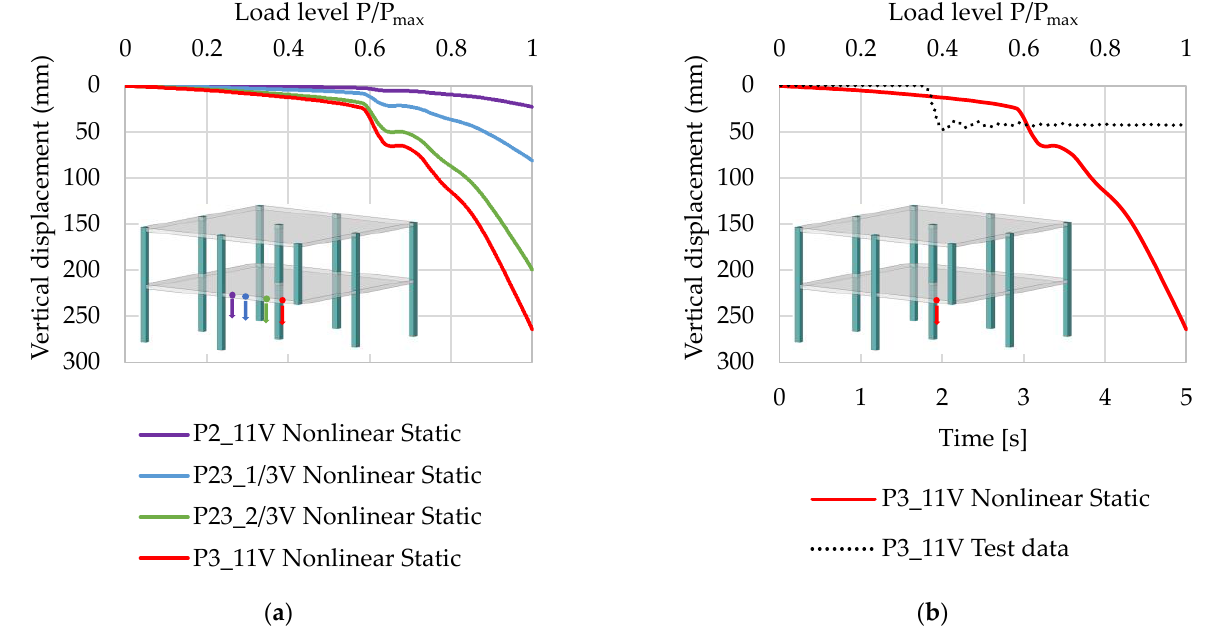
Figure 8. Vertical displacements obtained from nonlinear static analysis ( a ) and its comparison with test data ( b ).